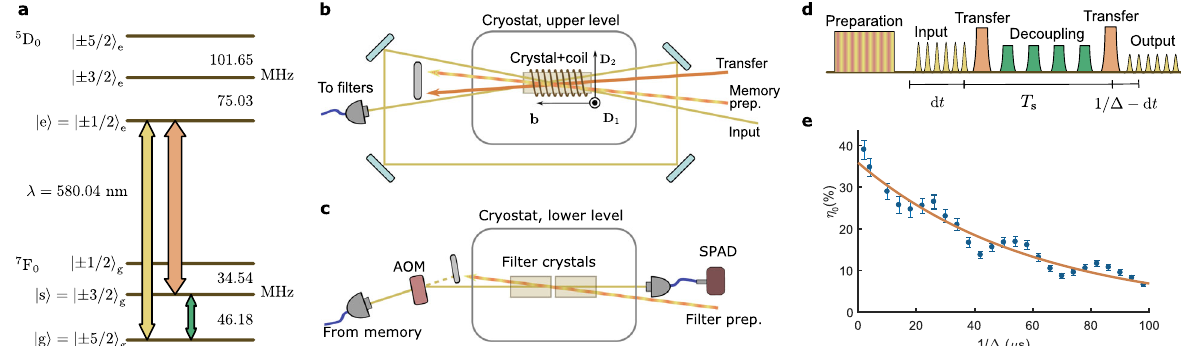
Fig. 1 System and setup. a Atomic energy structure of 151 Eu 3 + :Y 2 SiO 5 and transitions used in the memory protocol. b and c , sketches of the experimental setup around the memory and fi lter crystals, respectively. The crystals are glued on a custom mount with two levels at different heights, in the same cryostat. The memory crystal is at the center of a small coil used to generate the RF signal. A larger coil (not shown) on top of the cryostat generates a static magnetic fi eld along the D 1 axis of the Y 2 SiO 5 crystal. Optical beams are depicted with exaggerated angles for clarity. AOM: acousto-optic modulator; SPAD: single photon detector. d Sketch of the time sequence of pulses used for multimode spin-storage. e AFC ef fi ciency measured as a function of AFC time 1/ Δ , with bright input pulses and magnetic fi eld of 1.35 mT along D 1 . The solid line indicates the exponential fi t resulting in zero-time ef fi ciency η 0 = (36 ± 3)% and effective coherence time T AFC text for details. Error bars represent 95% con fi dence intervals. More information on the experimental setup and pulse sequences can be found in the Methods section and in Supplementary Notes 1 and